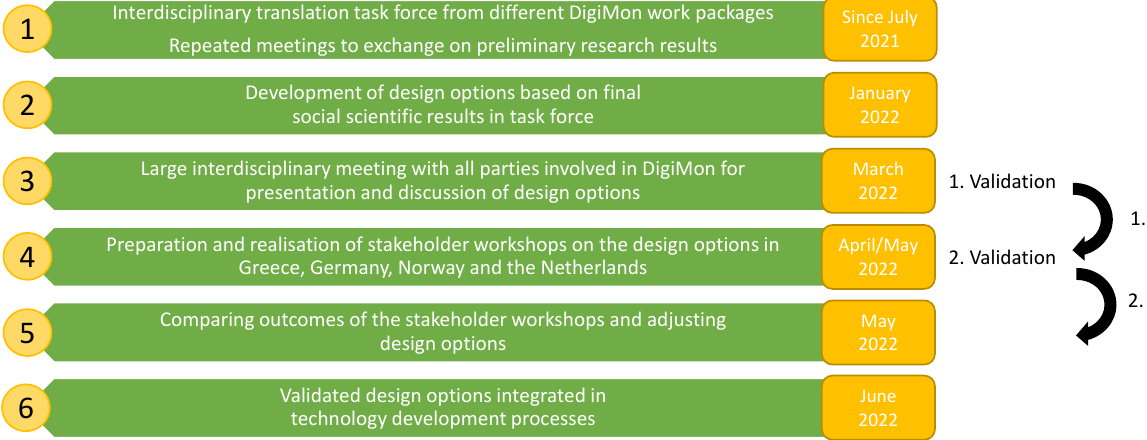
Figure 2. Overview of inter- and transdisciplinary translation process